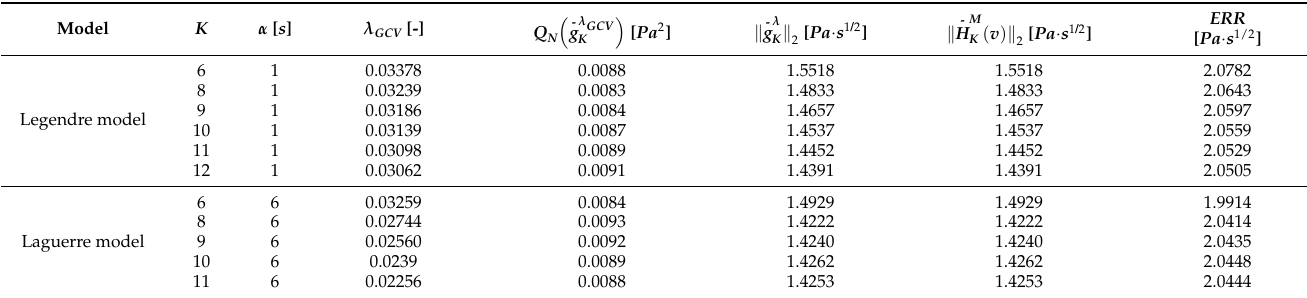
Table 1. The parameters of the optimal models in Example 1: time-scale factors α , numbers of model summands K , regularization parameter λ GCV and the approximation error indices: identification index Q